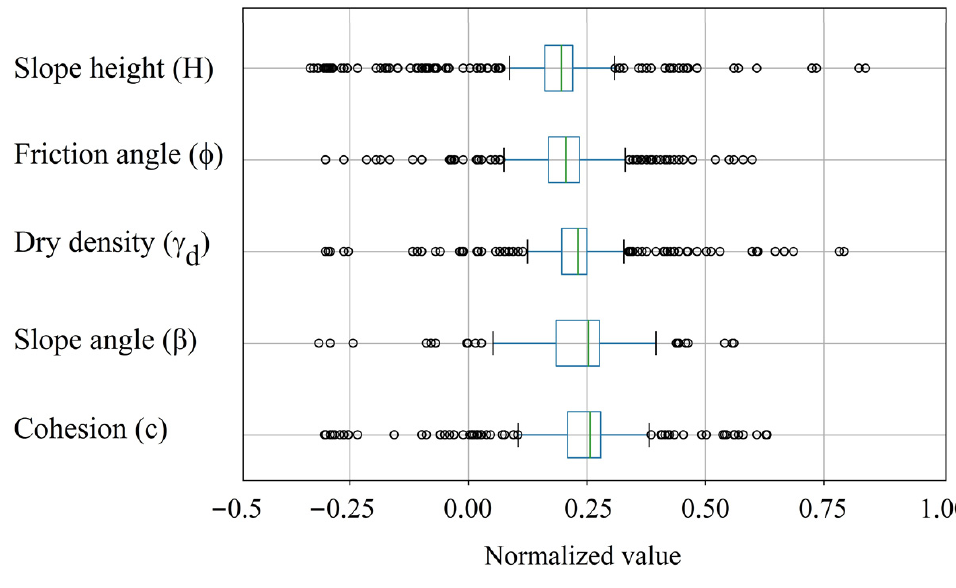
Figure 1. Results of the box diagram for the standardized data.